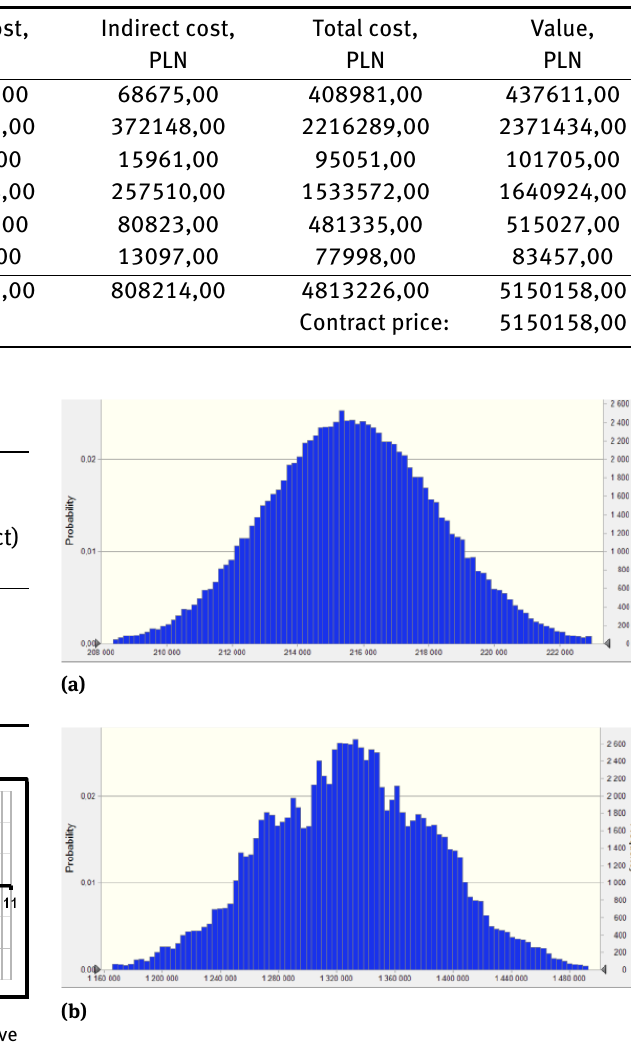
Table 3: The billing elements for lump sum contract with the relevant financial data.